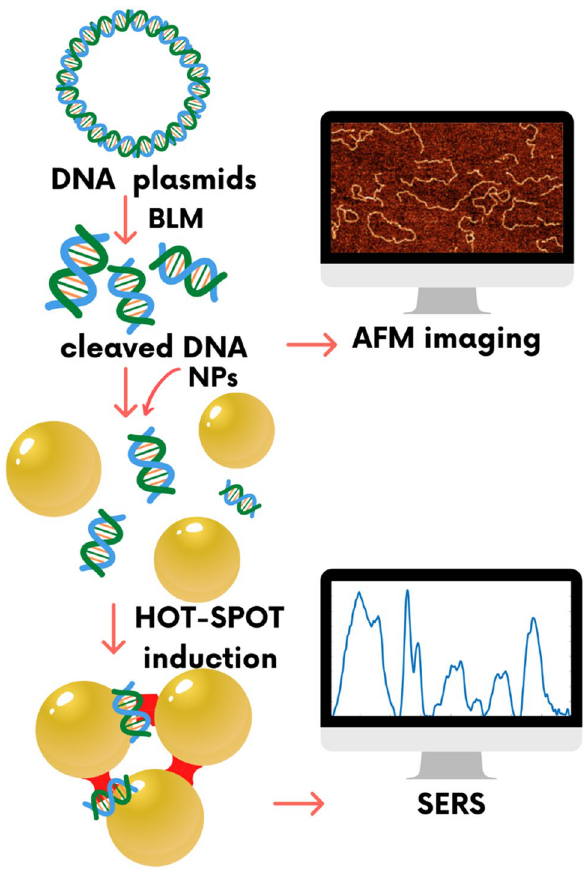
Figure 1. Scheme of concept of SERS and AFM experiments. The applied approach combines two independent experimental methods, SERS and AFM, in the detection of the DNA damage resulting from the induction of DSBs by bleomycin. AFM enables a visualization of the effect of DNA cutting by bleomycin, while SERS is sensitive enough to detect conformational rearrangements of DNA resulting from DSBs induction via